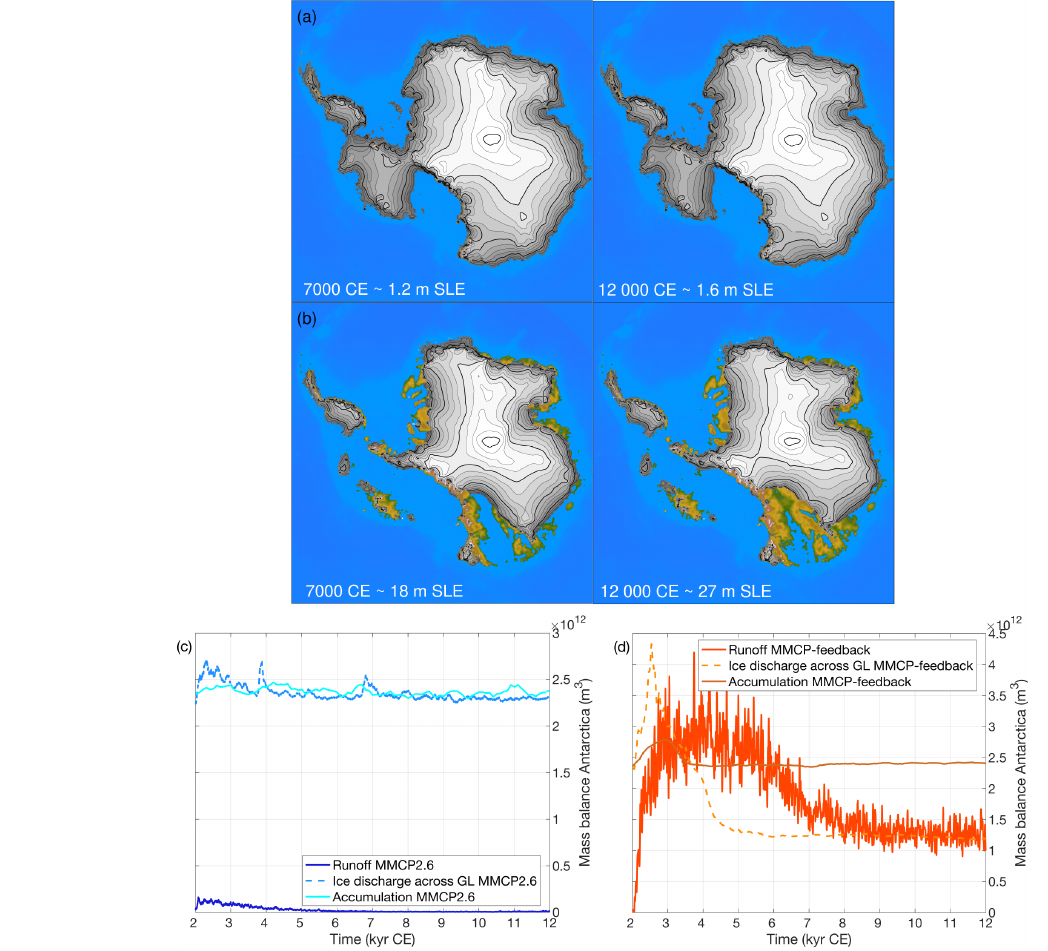
Figure 11. (a) Antarctic ice sheet configuration at 7000CE and 12000CE using scenario MMCP2.6 and (b) MMCP-feedback. Only grounded ice is shown. Main mass balance components (over grounded ice) explaining the change in ice sheet geometry for scenarios MMCP2.6 (c) and MMCP-feedback (d) . GL: grounding line. Note that the land–sea mask has not changed due to the change in GMSL but only due to isostatic